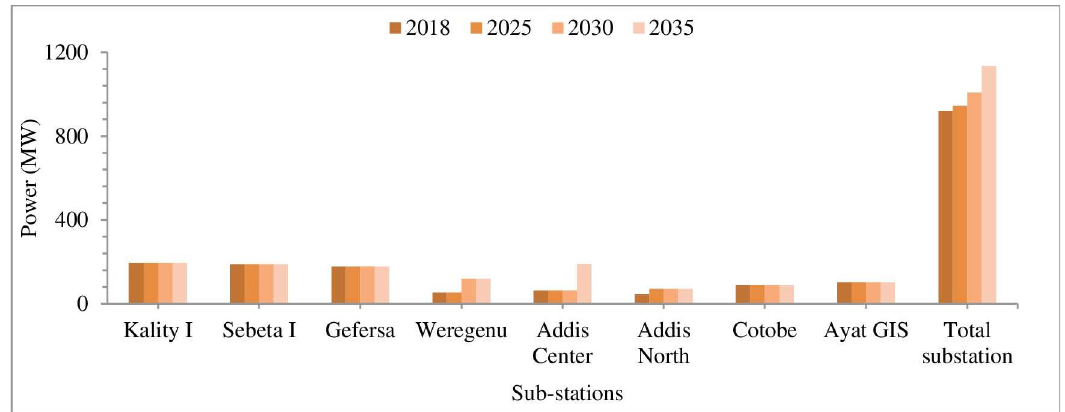
Fig 4. Power load of Addis Ababa city sub-stations. The total energy supply of sub-stations in 2030 and 2050 will be 8836 GWh (31 PJ) and 9943 GWh (36 PJ) respectively. For the respective years, the total power supply of Addis Ababa city are 1009 and 1135 MW respectively.